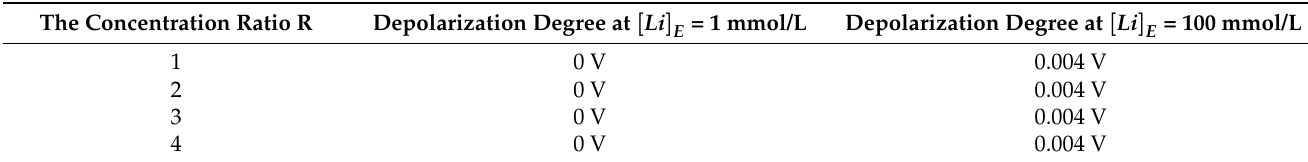
Table 19. The table shows the depolarization degree based on the classical transport of both isotopes as in graph (a) of Figure 8.